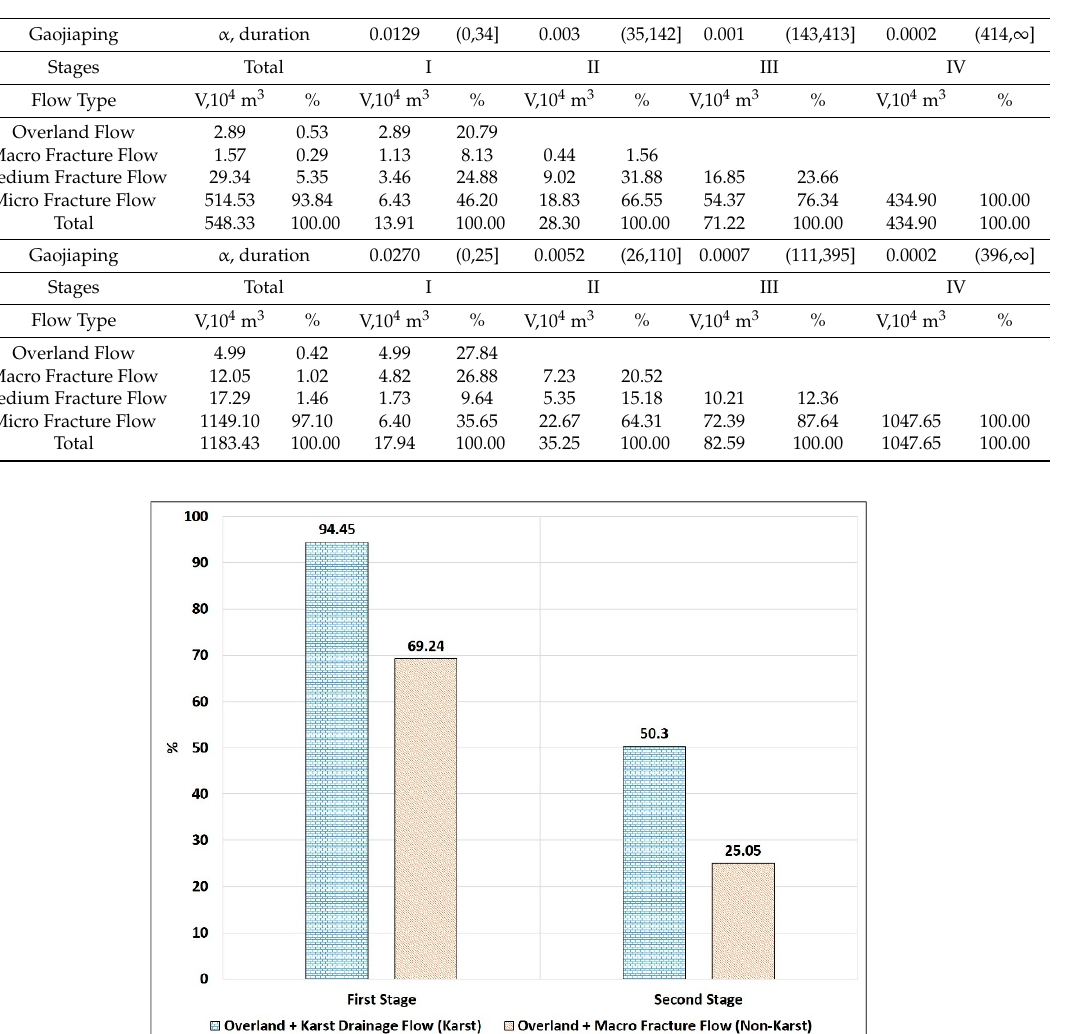
Figure 11. Contrast in Overland + Karst Drainage Flow Volume vs. Overland + Macro Fracture Flow Volume.